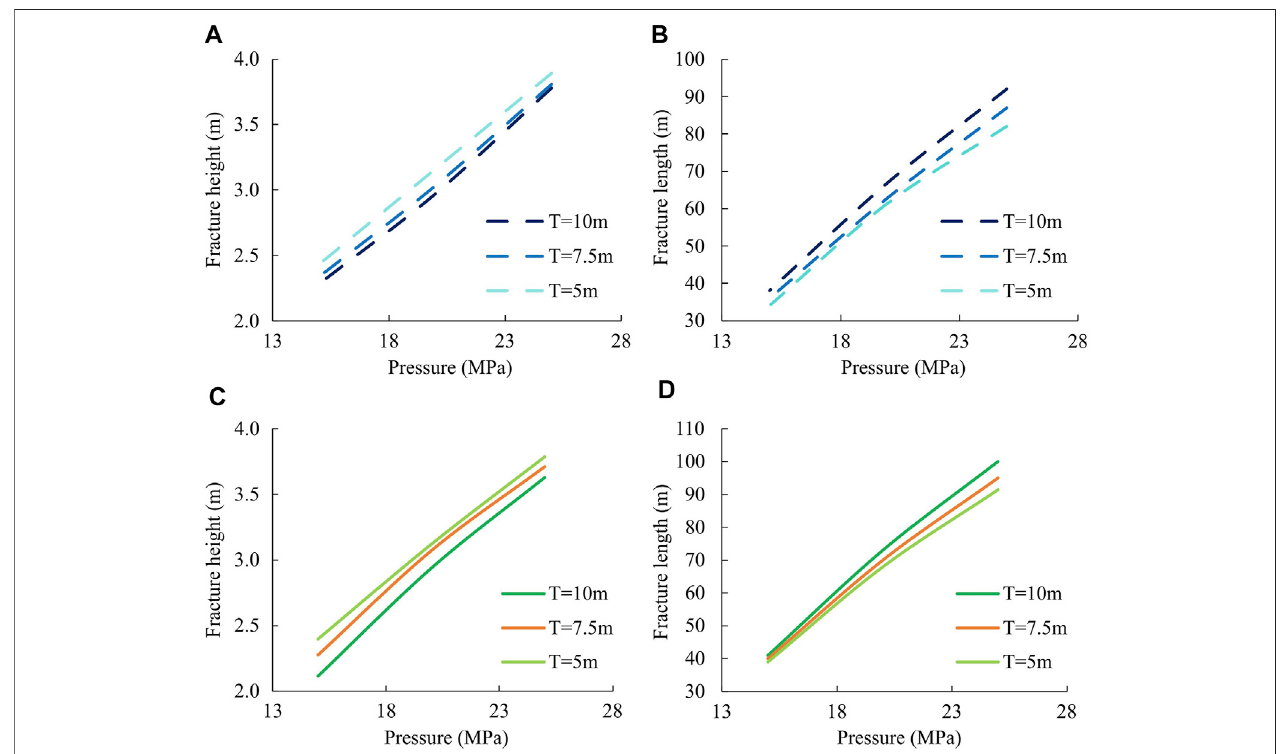
FIGURE13| Fractureparametersunderdifferentthicknessesoftheinterlayer (A) ThefractureheightoftheNo.9coalseam. (B) ThefracturelengthoftheNo.9coal seam. (C) The fracture height of the No. 13 coal seam. (D) The fracture length of the No. 13 coal seam.